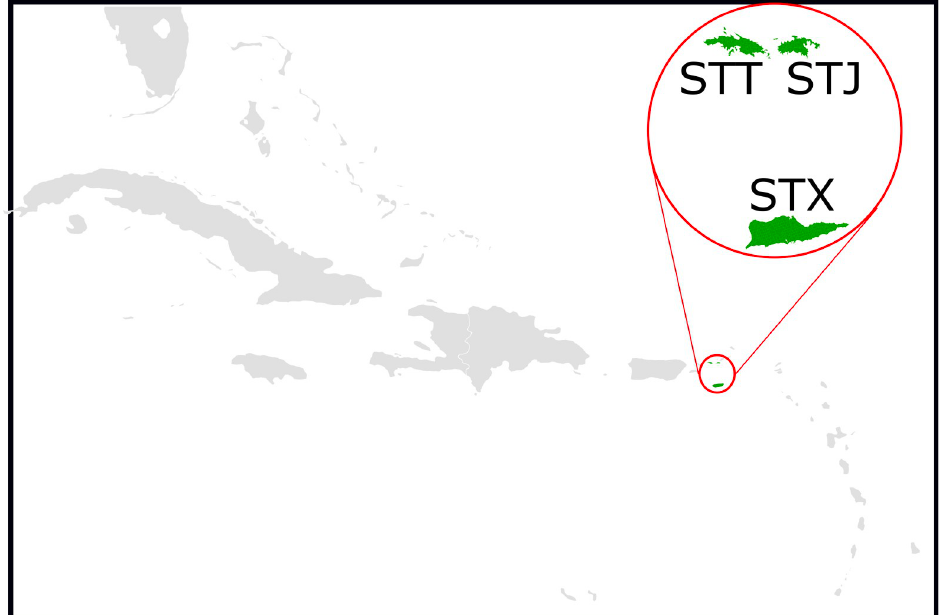
Fig 1. The location of the United States Virgin Islands in the Caribbean region, with the three islands St. Croix (STX), St. John (STJ), and St. Thomas labeled. Map base layers were obtained from https://commons.wikimedia.org/ wiki/File:BlankMap-Caribbean.svg and https://catalog.data.gov/de/dataset/tiger-line-shapefile-2017-state-united-